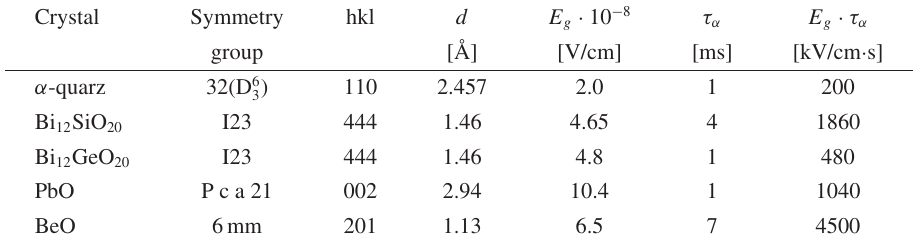
Table 1. Property of some crystals without a center of symmetry.